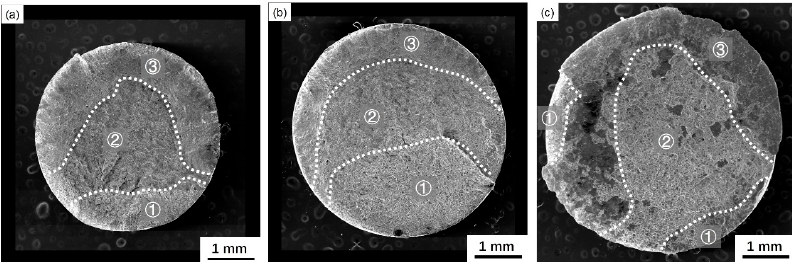
Figure 5. Macro fracture after creep tests. ( a ) Furnace cooling; ( b ) Air cooling; ( c ) Oil quenching. White dotted lines divide the fracture into three areas: ① The initial rupture area; ② The propagation area; ③ The final rupture area.